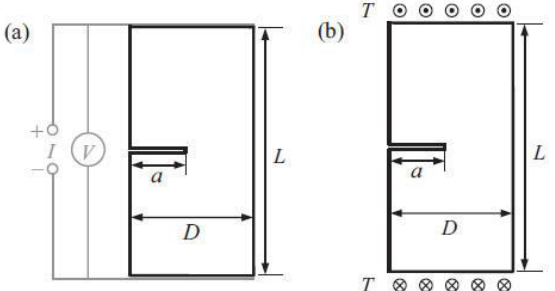
Figure 29. Sketch of damaged specimen with a notch. ( a ) Crack detection with conductive plates attached to the ends of the specimen; ( b ) Mathematical analogy of anti-plane shear applied to the ends of the specimen. Reprinted with permission from Ref. [111]. Copyright 2014 Elsevier.